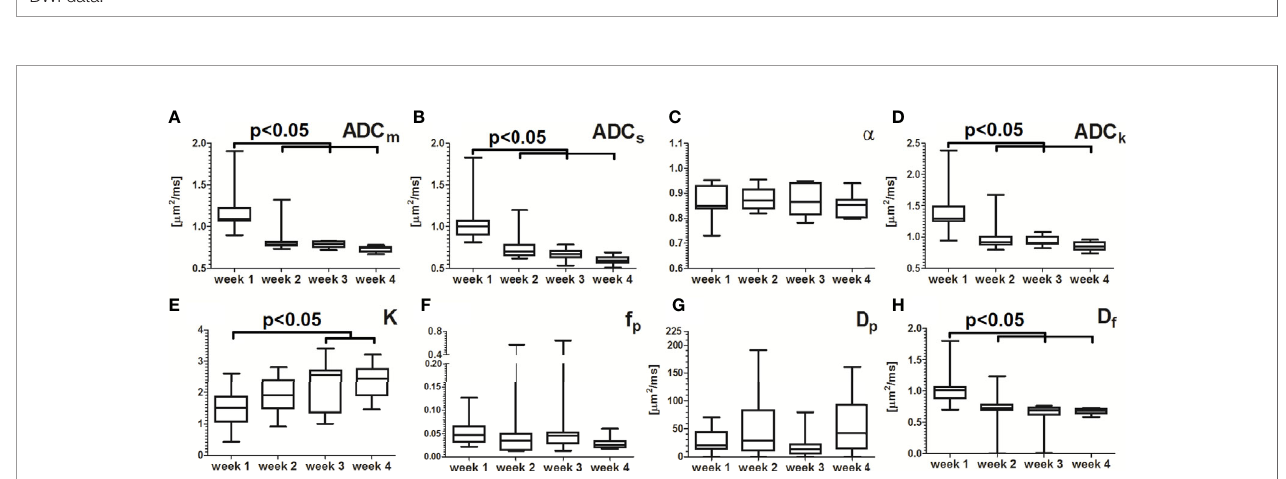
FIGURE 4 | Median values of regions of interest (n=11) derived from DWI data obtained using low b-values. Signi fi cant changes (p<0.05) were present in ADC m (part A ), ADC s (part B ), ADC k (part D ), and D f (part H ) values between week 1 and those from the weeks 2, 3 and 4. K (part E ) parameter differed signi fi cantly (p<0.05) between week 1 and weeks 3 and 4. The differences between weeks 2, 3 and 4 were not signi fi cant. The remaining differences in the fi tted values (alpha, part C ; Fp, part F ; Dp part G ) between weeks did not reach the level of statistical signi fi cance. The box extends from the 25 th to 75 th percentiles while the error bars extend from minimal to maximal